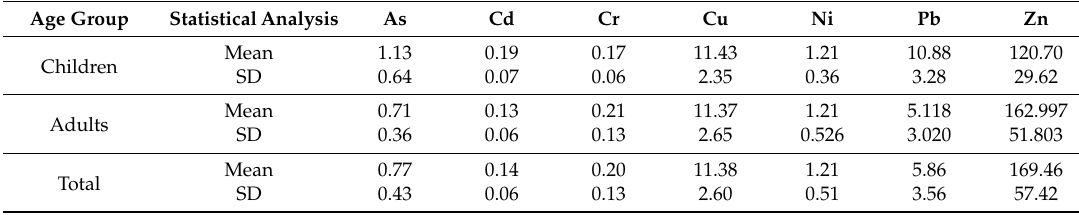
Table 3. Trace metals concentration of different age groups in human hair (mg · kg − 1 ). Age Group